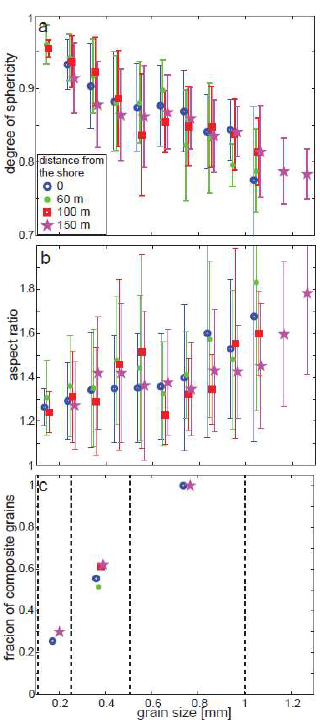
Figure 4. Petrographic characterization of grains at different locations along the transect. ( a ) Degree of sphericity (the ratio between the perimeter of a circle of the same area as the particle and the actual perimeter of the particle). ( b ) Aspect ratio (the ratio between the major and minor axis of the particle). Error bars indicate ± one standard deviation. For each grain size fraction, the two-sample Smirnov-Kolmogorov test confirmed that samples from different locations were drawn from the same distribution ( p < 0.05). ( c ) Fraction of composite grains (number of grains that are composite divided by the total number of grains) measured at different locations along the transect. Colored symbols in all panels mark the same locations as shown in the legend of panel